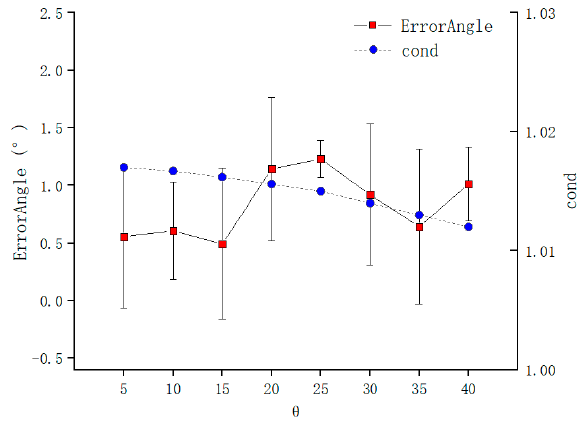
Figure 15. Error of TCPF with θ .